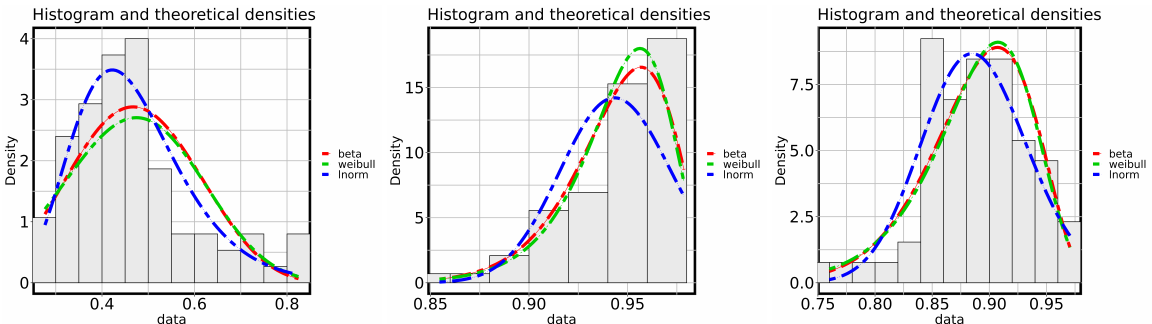
Figure 5. Fitting PDF to fitness with various theoretical functions after 36 epochs of training. From left to right are results using Sentinel-1, Sentinel-2 and both sensors. The red, blue and green colors correspond to Beta, Log-normal and Weibull distributions, respectively.